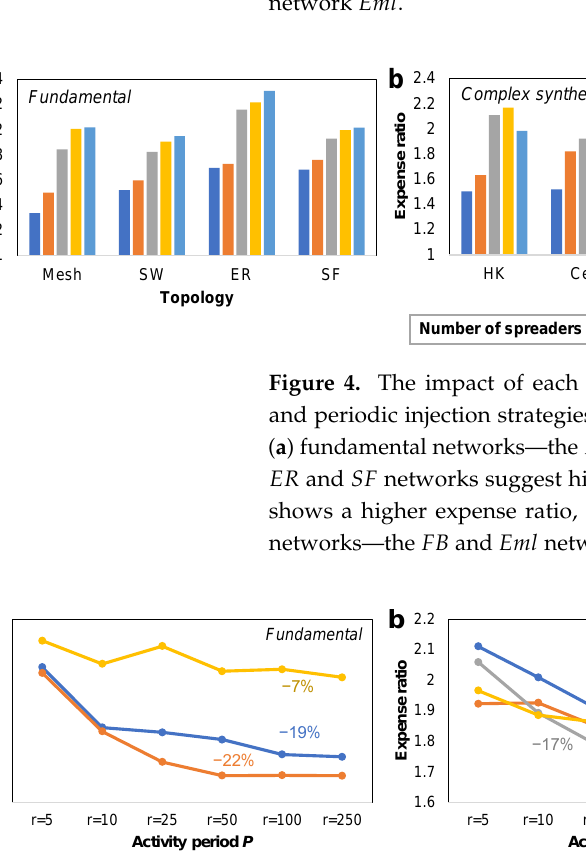
Figure 3. Comparison between the two injection strategies, in terms of measured indoctrination expense E , highlighting the increase in the activity period P . Examples are chosen from each network category with a different number of spreaders N s : ( a ) small-world SW ; ( b ) Holme–Kim HK ; ( c ) Email network Eml .